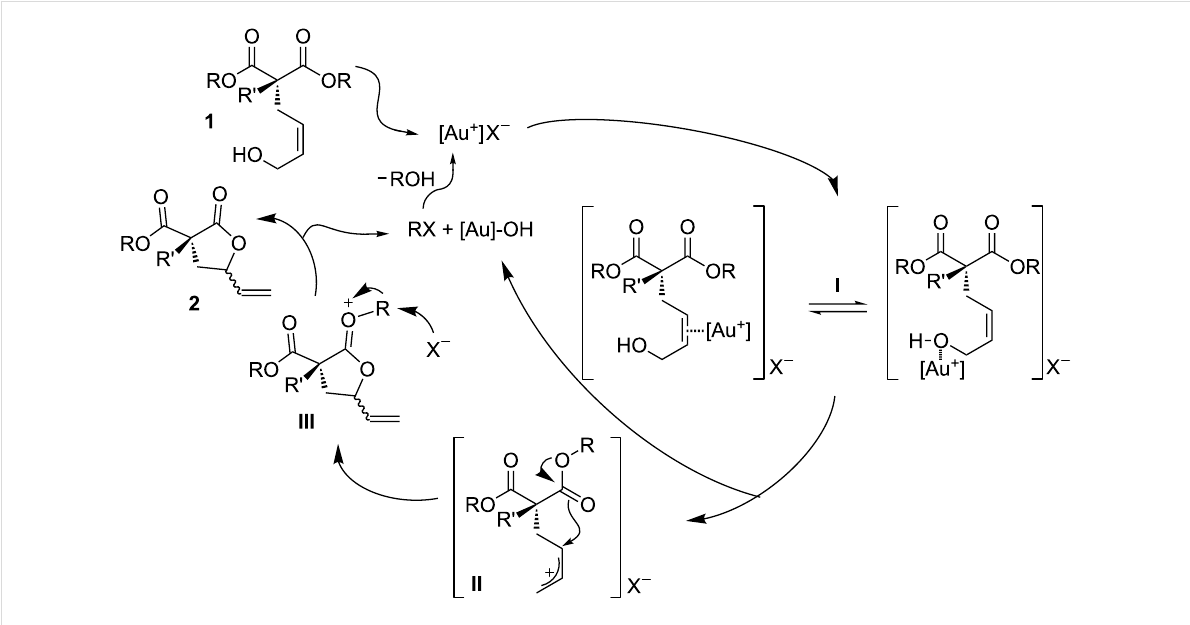
Scheme 2: Mechanistic sketch of the gold-promoted oxaallylic alkylation